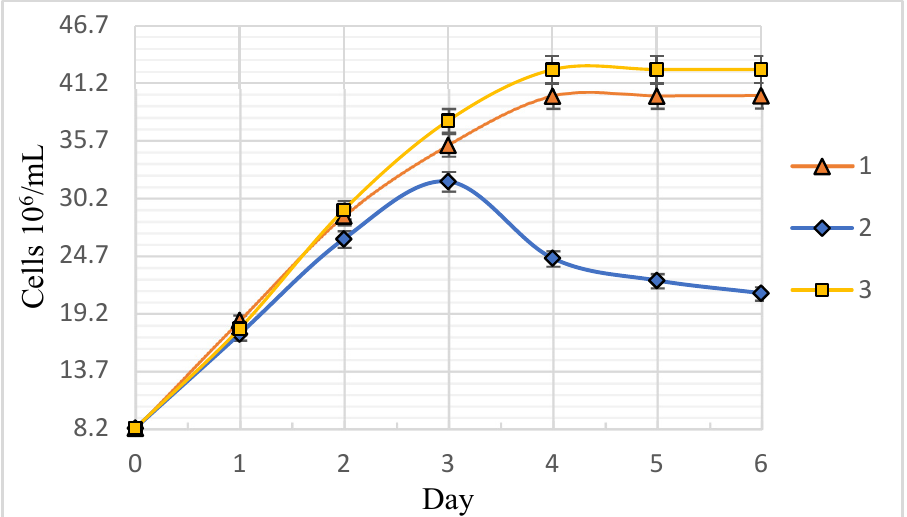
Figure 1. Influence of the additives introduced into the culture medium on the dynamics of the population growth of C. vulgaris BIN microalgae: 1, control (no additives); 2, H 2 O 2 additive; 3, H 2 O 2 additives + pyridoxine.